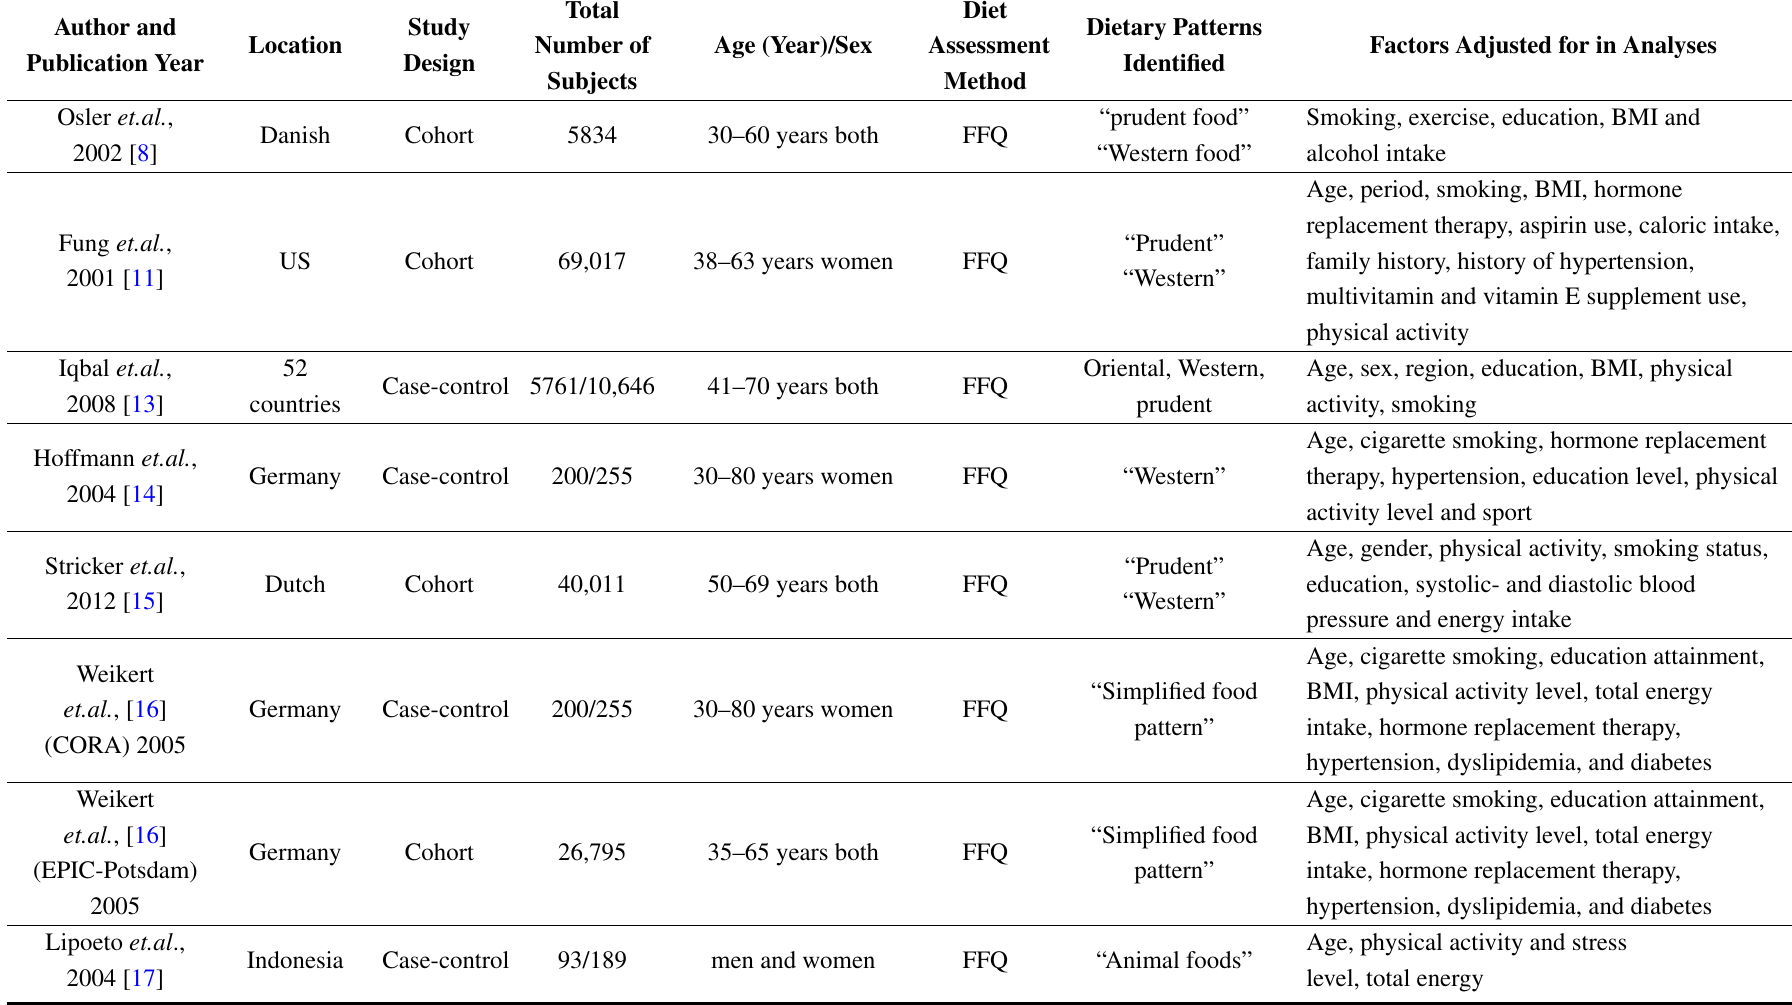
Table 1. Characteristics of 35 studies included in the meta-analysis